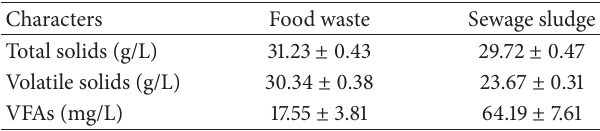
Table 1: The characteristics of food waste and feed sludge for anaerobic